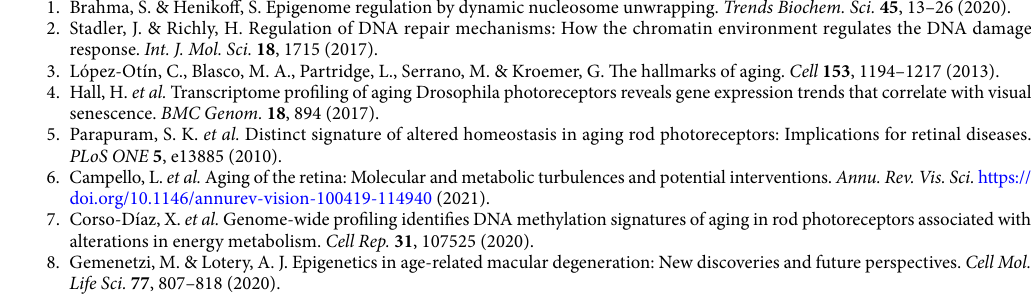
Western blot and luciferase assays. Histones were extracted using a modified acid extraction protocol. Briefly, five third instar larvae were homogenized in 200 µL of Extraction buffer (1× PBS, 0.5% Triton X-100, 2 mM PMSF) using a motorized pestle motor, and incubated for 10 min at 4 °C with constant rotation. Sam- ples were centrifuged at 6500× g for 10 min at 4 °C and the pellet was resuspended in 100 µL of 0.4N HCl and incubated on ice for 5 min, followed by centrifugation at 6500× g for 10 min at 4 °C. The supernatant was trans- ferred to a fresh tube and neutralized with NaOH, then analyzed by SDS-PAGE and western blotting using H3 (Abcam; ab1791) and H3K36me3 antibodies (Abcam; ab9050). Luciferase assays were performed as previously described 26 . Full western blots corresponding to cropped panels are shown in Supp. Fig. 4. NIE and ChIP‑seq and bioinformatics analysis. NIE and ChIP-seq was performed as previously described 15 . Detailed ChIP-seq instructions are available at: https:// www. proto cols. io/ view/ in- vivo- tissue-